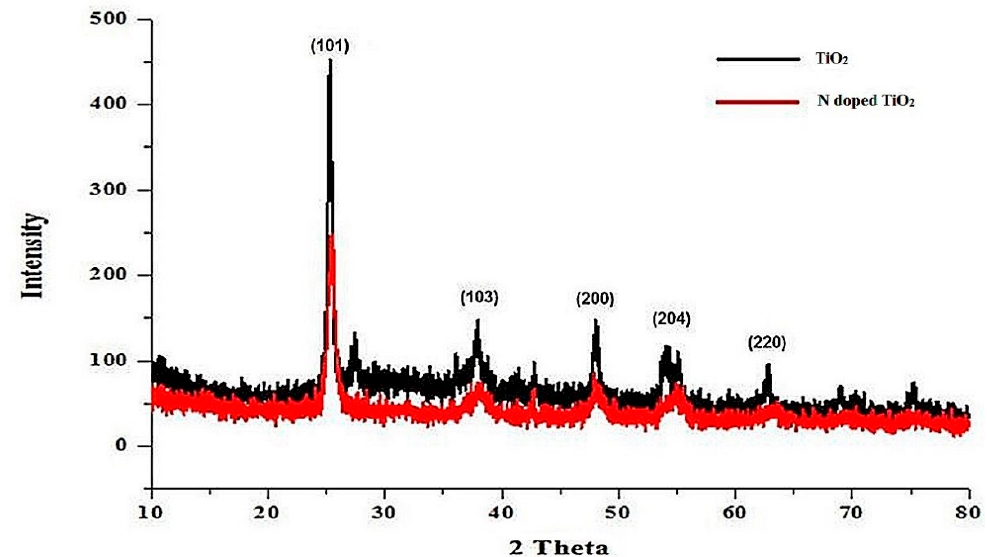
Figure 1. XRD pattern of TiO 2 nanoparticles and N-doped TiO 2